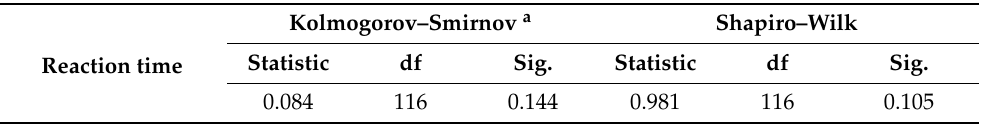
Table 3. Normality tests of the reaction